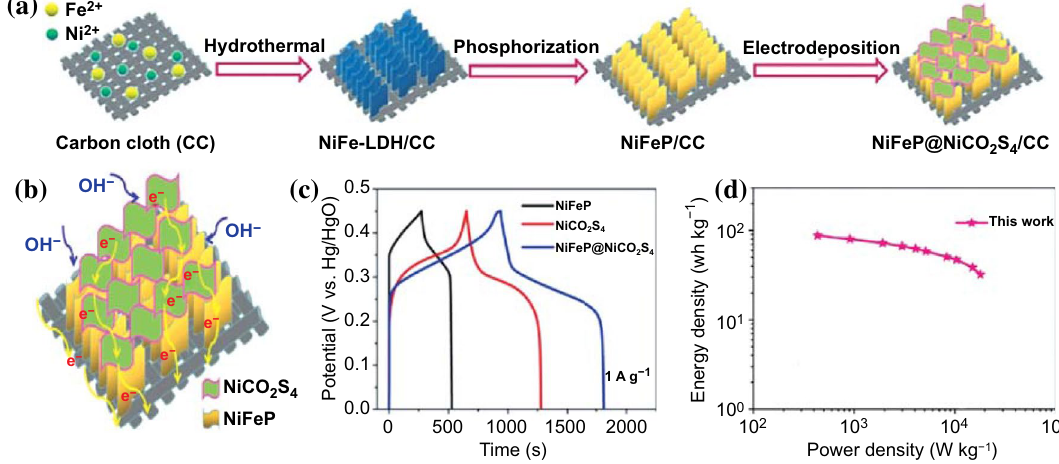
Fig. 15 a Schematic of the NiFeP@NiCo 2 S 4 hybrid nanosheets synthesis process. b Schematic description of charge storage and transfer advan- tages of NiFeP@NiCo 2 S 4 /CC electrode. c GCD of NiFeP/CC, NiCo 2 S 4 /CC, and NiFeP@NiCo 2 S 4 /CC electrodes at 1 A g −1 . d Ragone plot of the e NiFeP@NiCo 2 S 4 /CC//OPC-850 ASCs and a comparison with previous works. Adapted with permission from Ref. [149] Copyright 2020